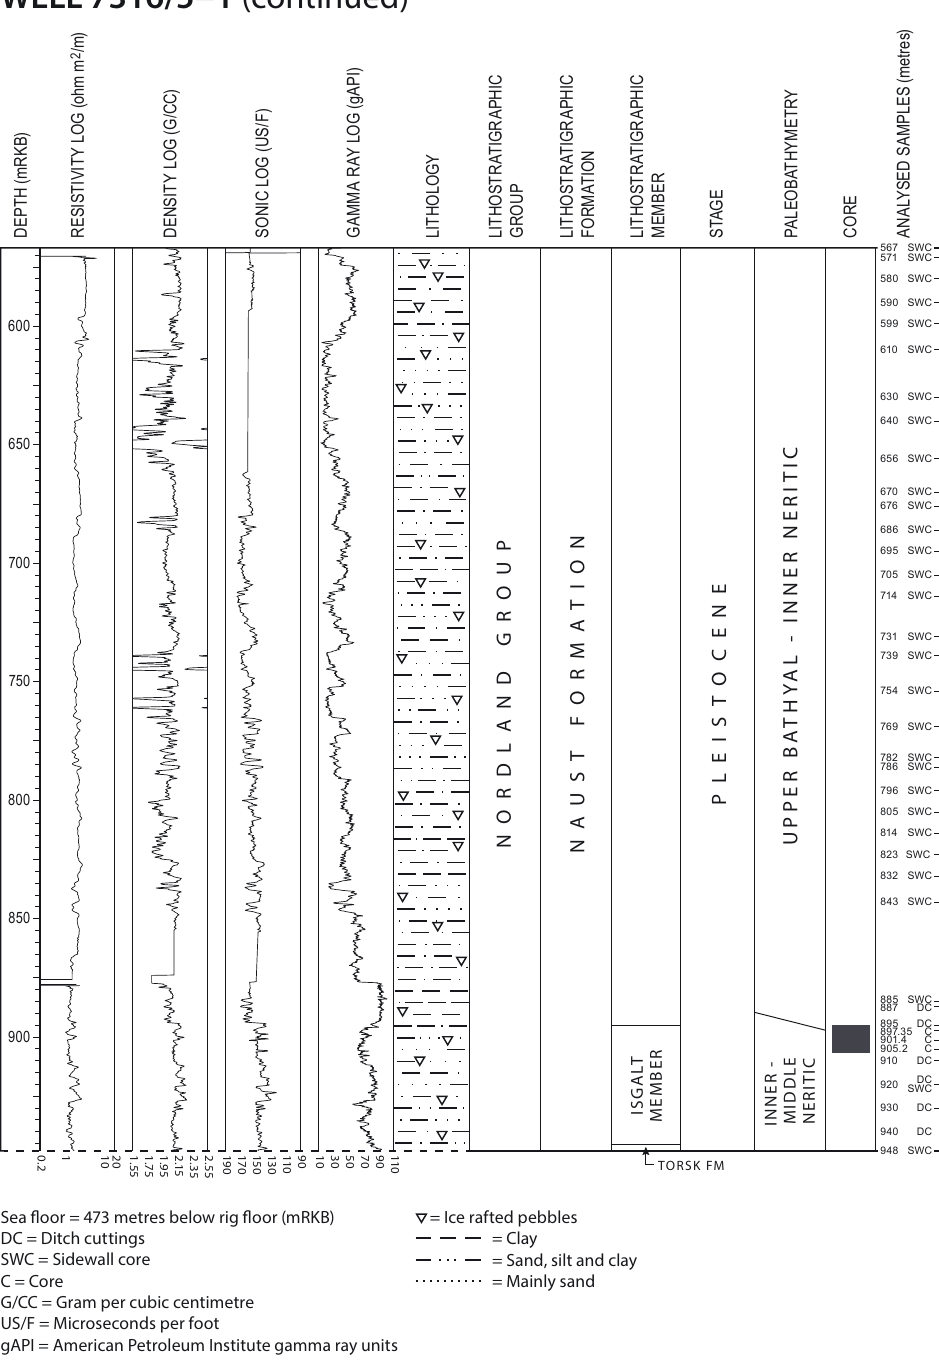
Figure 15. Well summary figure including resistivity log, density log, sonic log, gamma-ray log, lithology, litho- stratigraphic units, stage, paleobathymetry, core and analysed samples for the upper part of the investigated sequence in well 7316/5–1 (Pleistocene) including the well type section for the Isgalt Member and the upper part of the supplementary well reference section for the Torsk Formation (modified after Eidvin et al., 1995, 1998b,